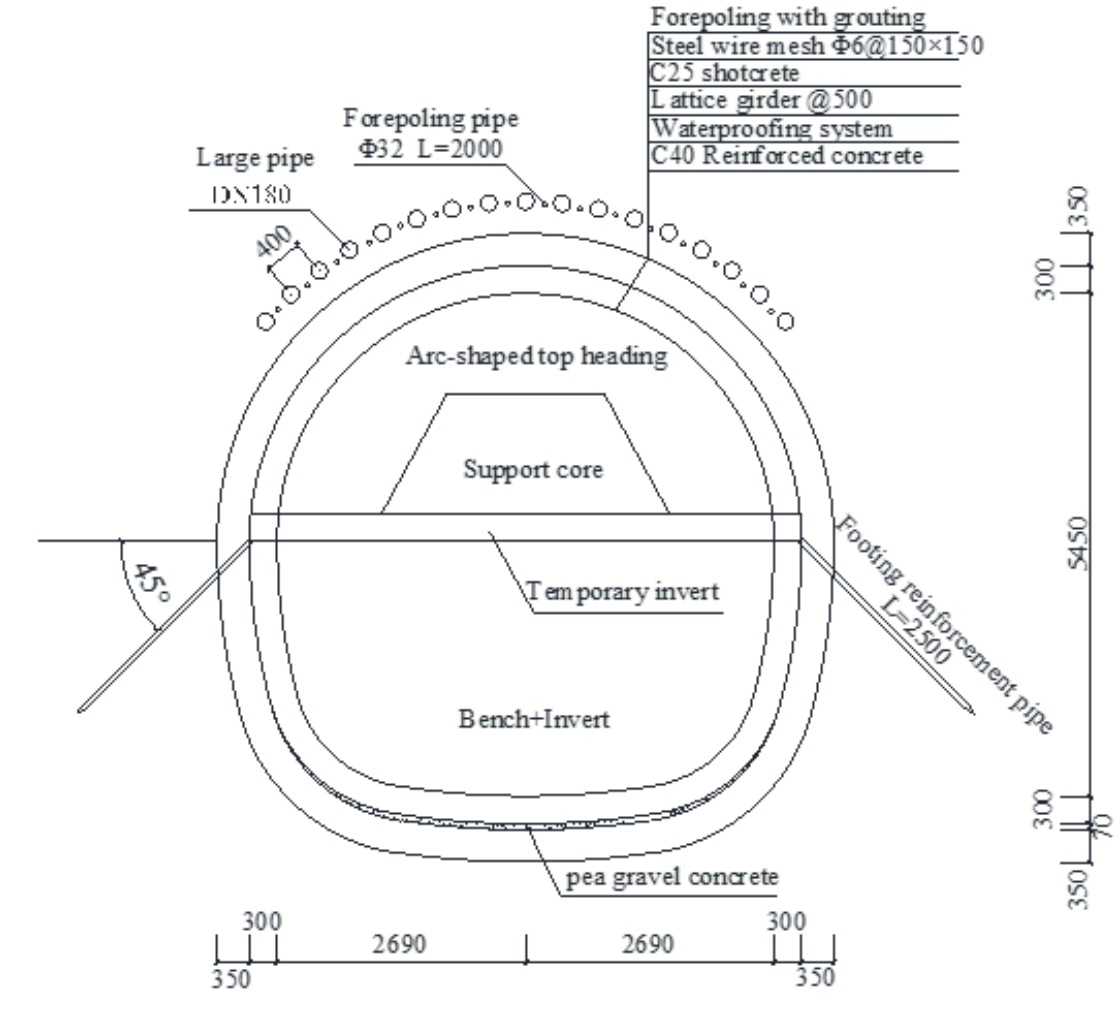
Figure 3. Cross-section of the new tunnel (unit: mm).